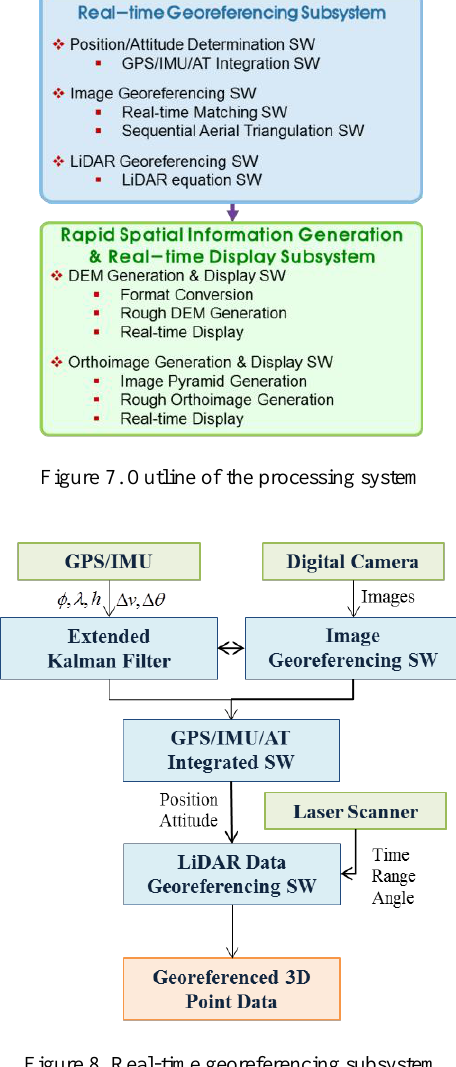
Figure 8. Real-time georeferencing